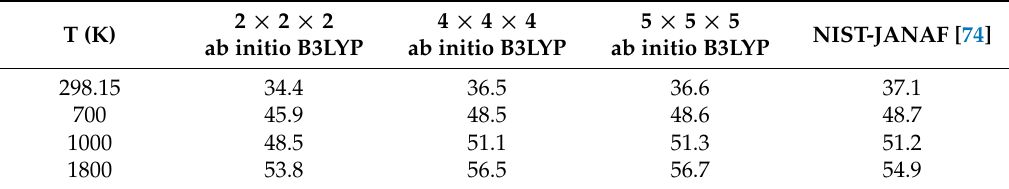
Table 3. Ab initio B3LYP isobaric heat capacity (C P ) of MgO, as obtained in this work by phonon dispersion calculation with 2 × 2 × 2, 4 × 4 × 4 and 5 × 5 × 5 supercells. Tabulated values by NIST-JANAF [74] are also shown for